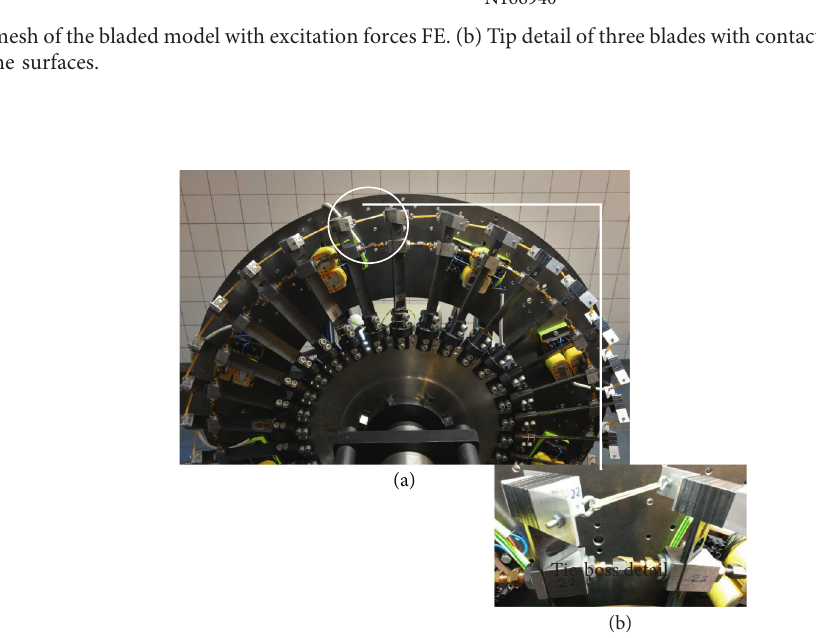
Figure 4: Test rig views. (a) The bladed wheel with tie-boss interconnections. (b) Tie-boss view (detail) with prestress strings. Figure 4 is reproduced from